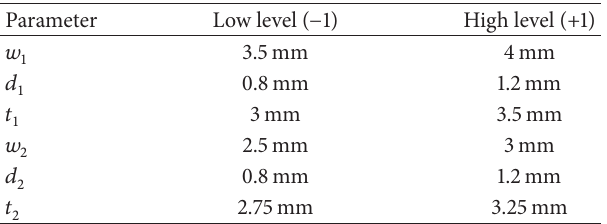
Table 4: Ranges for the design parameter of the dual-antenna